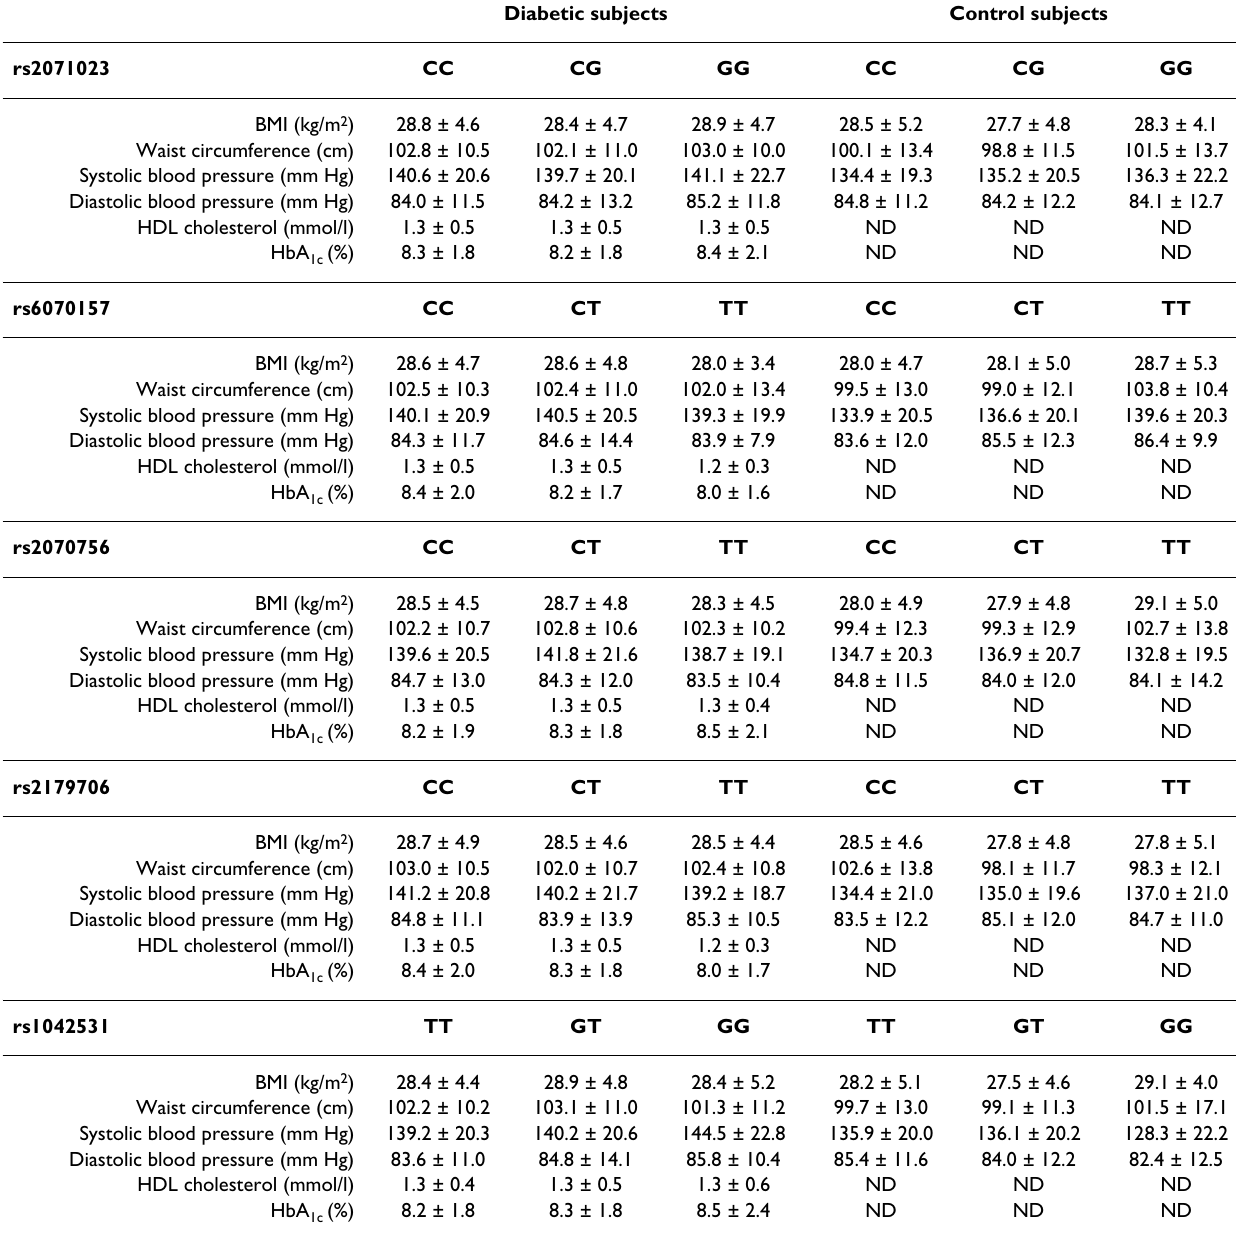
Table 2: Clinical characteristics of subjects studied Diabetic subjects Control